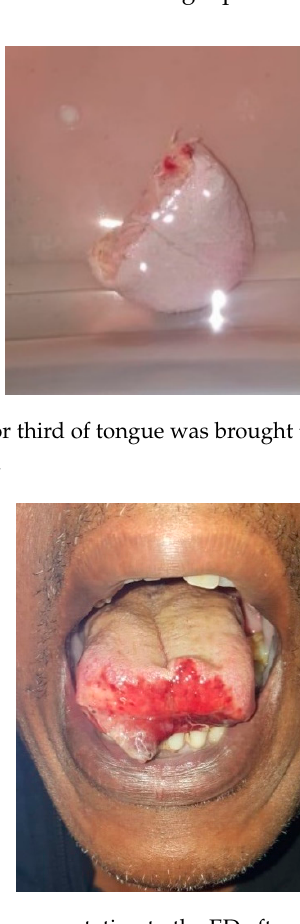
Figure 2. The patient following presentation to the ED after an alleged human bite to the tongue.